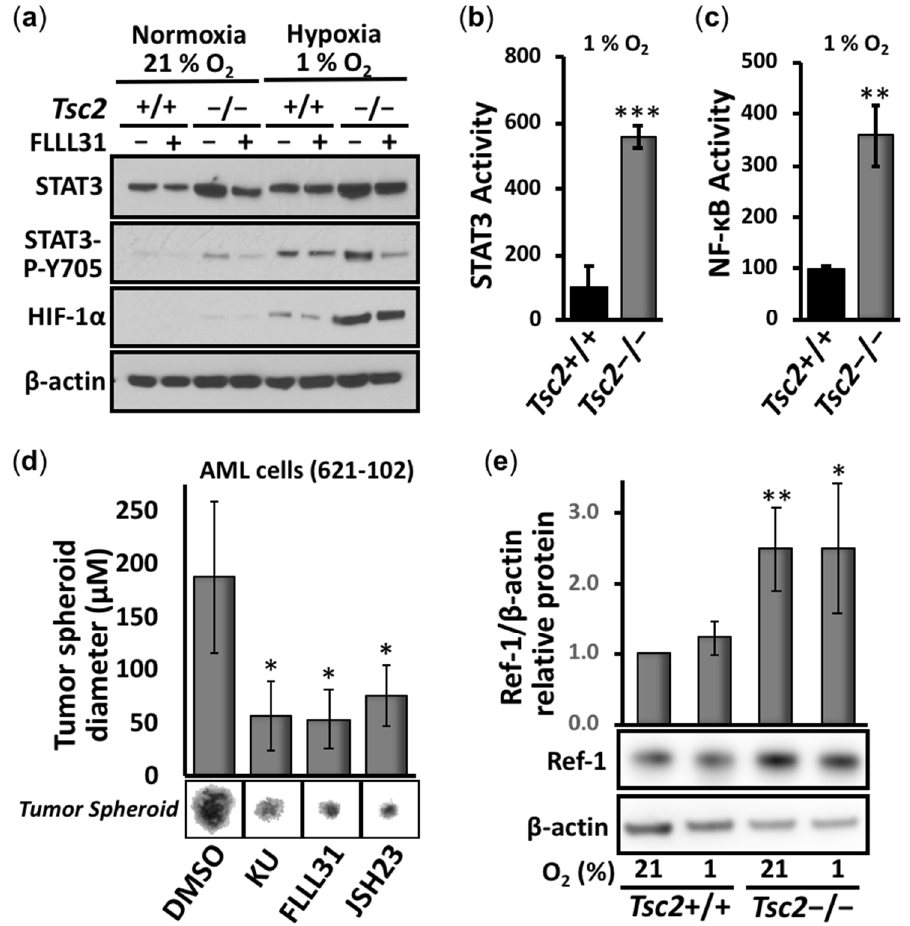
Figure 1. STAT3, HIF-1 α , NF- κ B, and Ref-1 are possible drug targets in TSC. ( a ) By Western blot, the total STAT3, HIF-1 α , β -actin, and P-Y705 STAT3 were determined in Tsc2 +/+ and Tsc2 − / − MEFs treated with either DMSO or 5 µ M FLLL31 in either 21 or 1% oxygen, where indicated, for 18 h. Tsc2 +/+ and Tsc2 − / − MEFs were transiently transfected with ( b ) STAT3 and ( c ) NF- κ B luciferase vector and subjected to hypoxia (1% O 2 ) for 18 h ( n = 3). ( c , d ) In vitro tumor formation assays were carried out in 621-102 AML cells over 4 weeks in the presence of DMSO, 1 µ M Ku-0063794 (KU), 5 µ M FLLL31, and 30 µ M JSH23. Diameters were measured in Image J ( n = 30). ( e ) By Western blotting, the relative protein levels of Ref-1 normalized to β -actin were determined in Tsc2 +/+ and Tsc2 − / − MEFs in normoxic and hypoxic conditions (21 and 1% oxygen) ( n = 3). The densitometry of protein bands was measured in Image J. For all graphs, error bars represent standard deviations (SDs); * p < 0.05, ** p < 0.01, *** p < 0.001 compared to DMSO or wild type. Tumor formation assays were carried out in angiomyolipoma (AML) cells from an